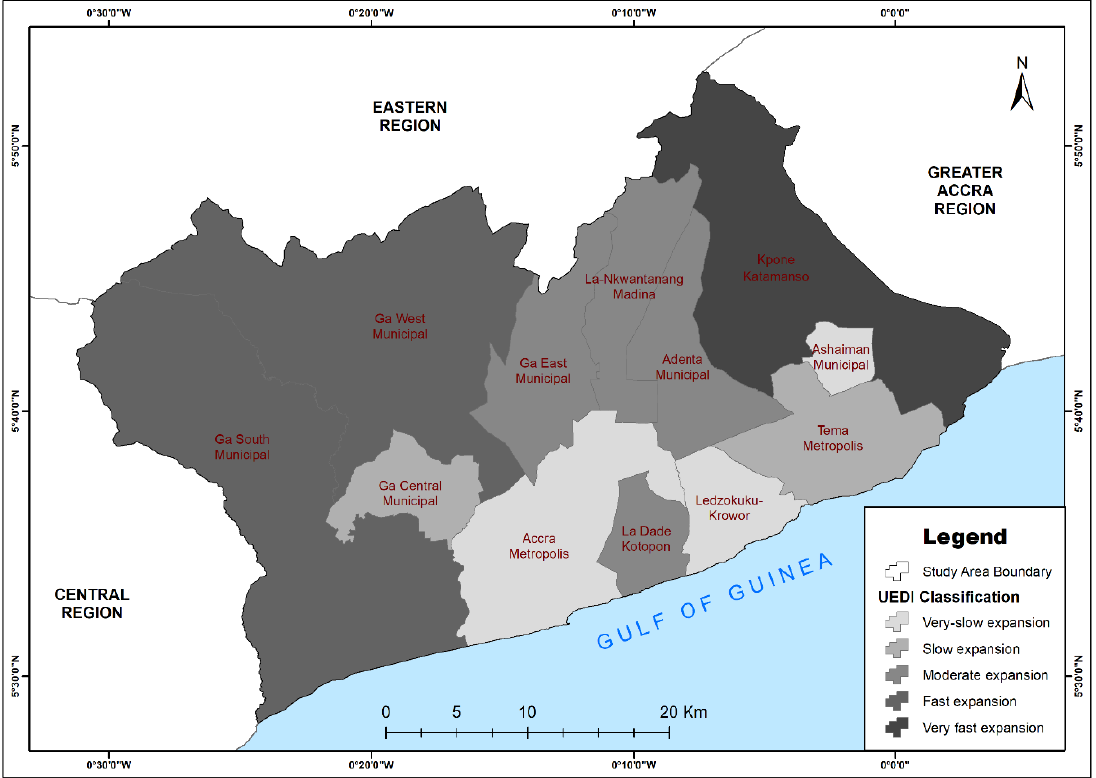
Figure 5. Pattern and direction of urban expansion in GAMA, 2008–2017.